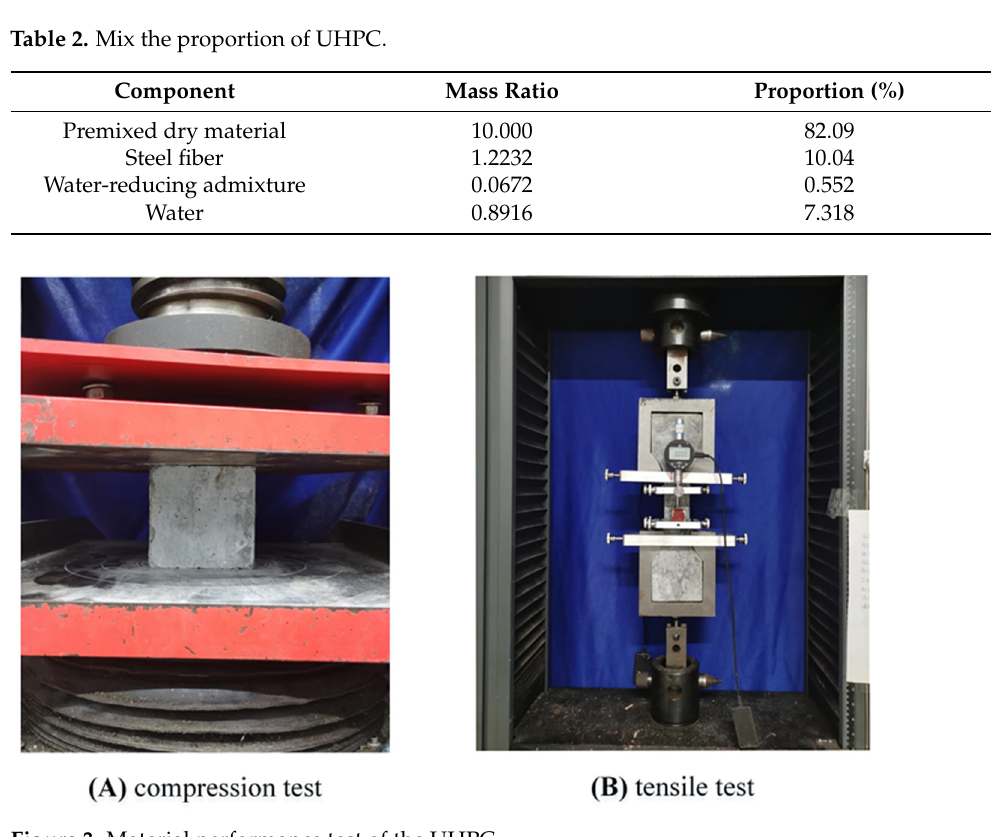
Figure 2. Reinforcing diagram of the specimen.